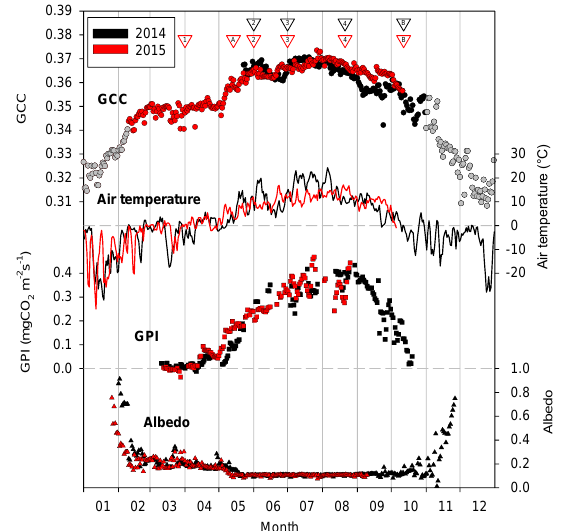
Figure 8. Mean daytime (10:00–14:00, local winter time) GCC (crown camera) together with the daily mean air temperature (at 18m), gross photosynthesis index (GPI) and albedo in 2014–2015 at the forest site. The triangles indicate the start dates of visually ob- served phenological phases (1 – bud burst, 2 – bud growth, 3 – shoot growth, 4 – old needle browning) and snow status (A – snowmelt, B – snow appearance). The grey circles indicate the wintertime data that are influenced by an insufficient light